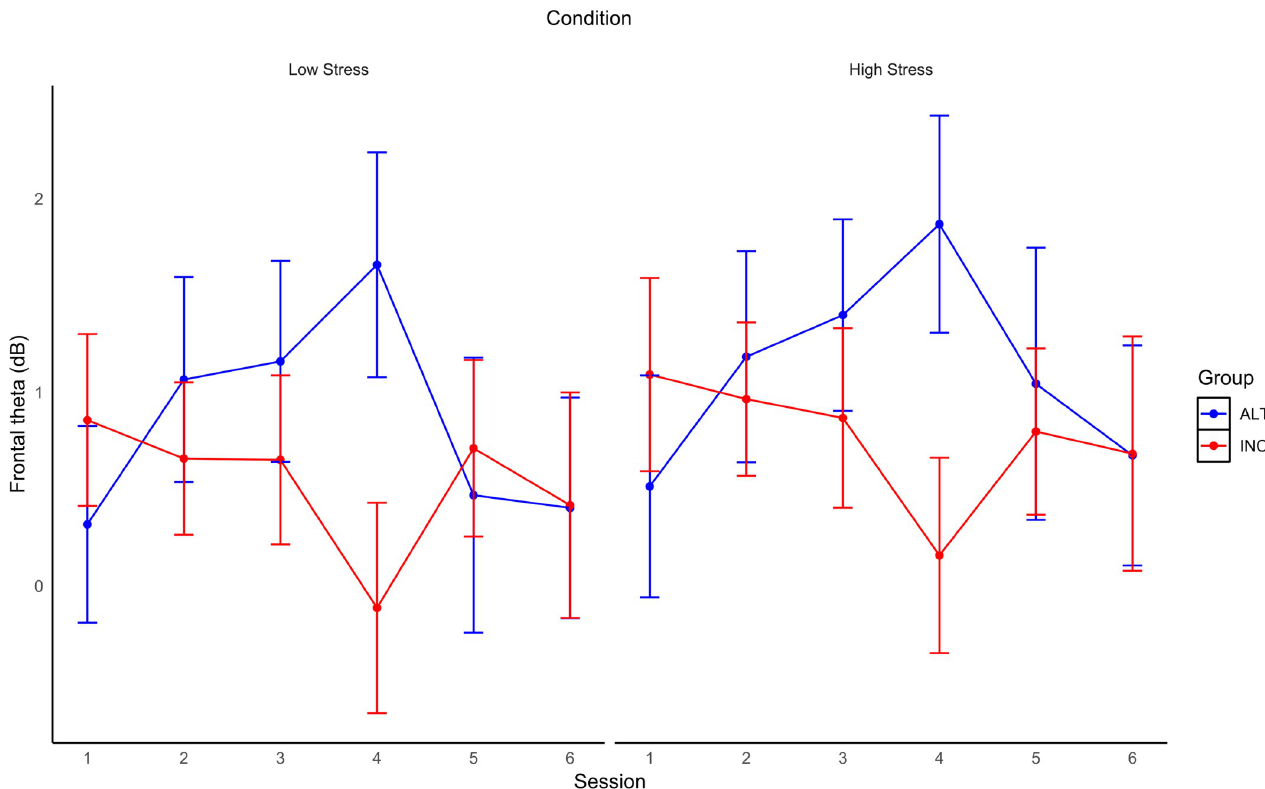
Fig 6. Fm θ changes across sessions in low and high time-stress conditions for each group during SH. Changes in Fm θ over Sessions during Go-NoGo shooting task in Low (left) and High (right) time-stress conditions for each Group (error bars are SE).